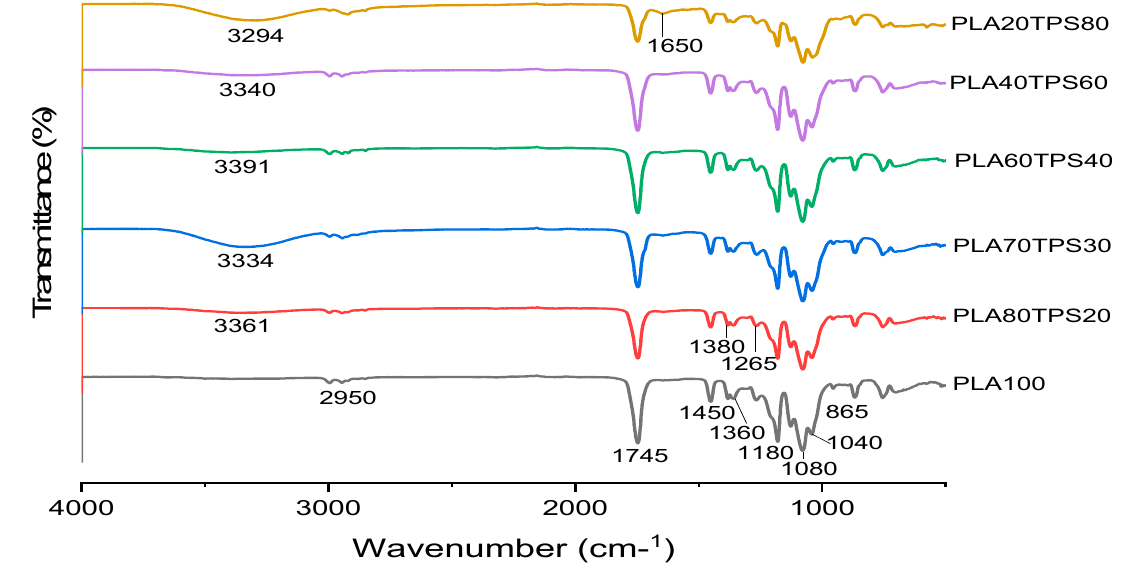
Figure 2. FTIR spectra of PLA100 and different ratios of PLA/TPS blend bionanocomposites.